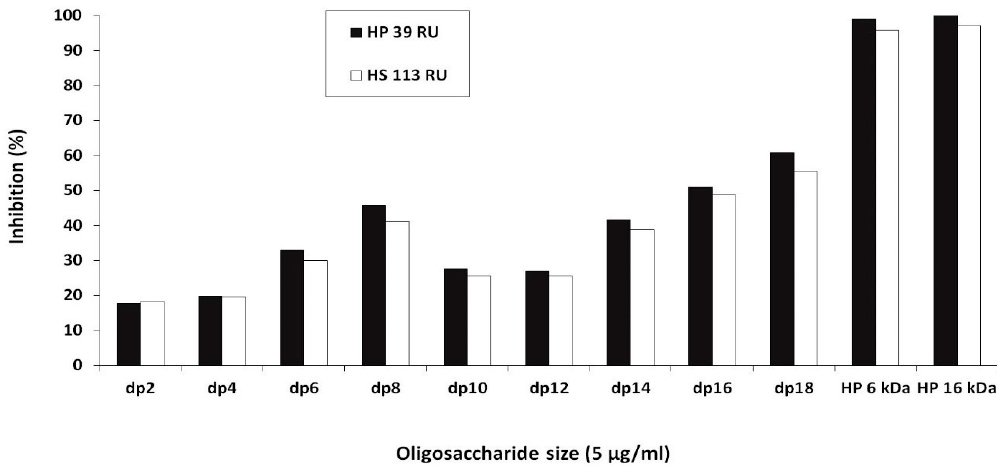
Figure 1. Surface plasmon resonance (SPR) inhibition assays. Inhibition of the binding of recombinant human procollagen C-proteinase enhancer-1 (PCPE-1) to biotinylated heparin (HP) and heparan sulfate (HS) captured on a streptavidin sensor chip (39 and 113 resonance units (RU) respectively) by HP oligosaccharides of different degrees of polymerization (dp2 ‒ dp18) and by HP (6 and 16 kDa) at a concentration of 5 µg/mL.